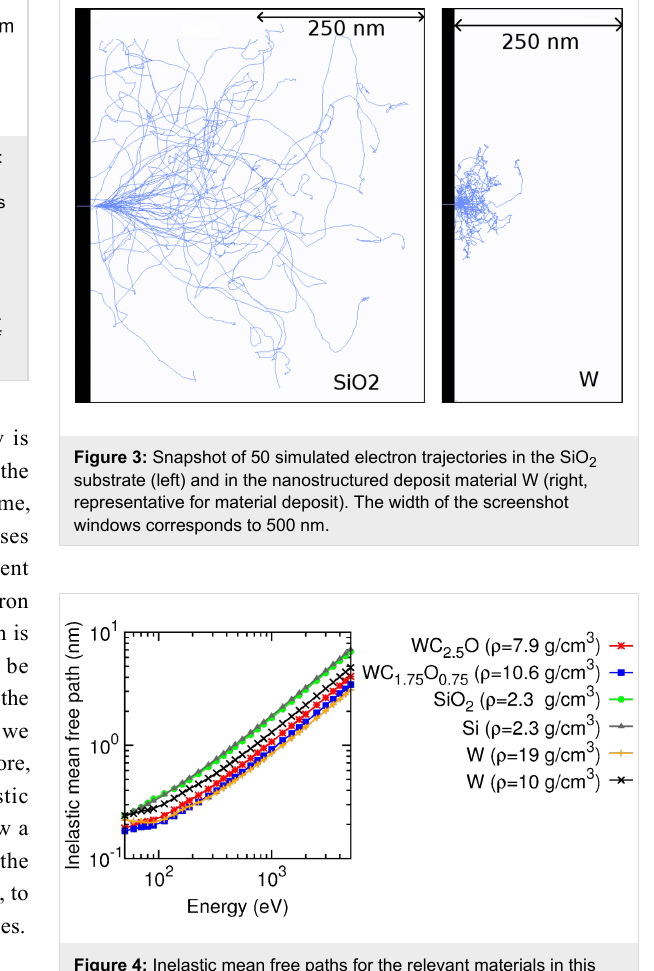
Figure 4: Inelastic mean free paths for the relevant materials in this work presented in the usual log–log scale. The tungsten oxycarbide compositions WC 2.5 O and WC 1.75 O 0.75 correspond to the samples with the lowest and highest density in Table 1, respectively. The two curves with cross symbols show the variation due to a density change